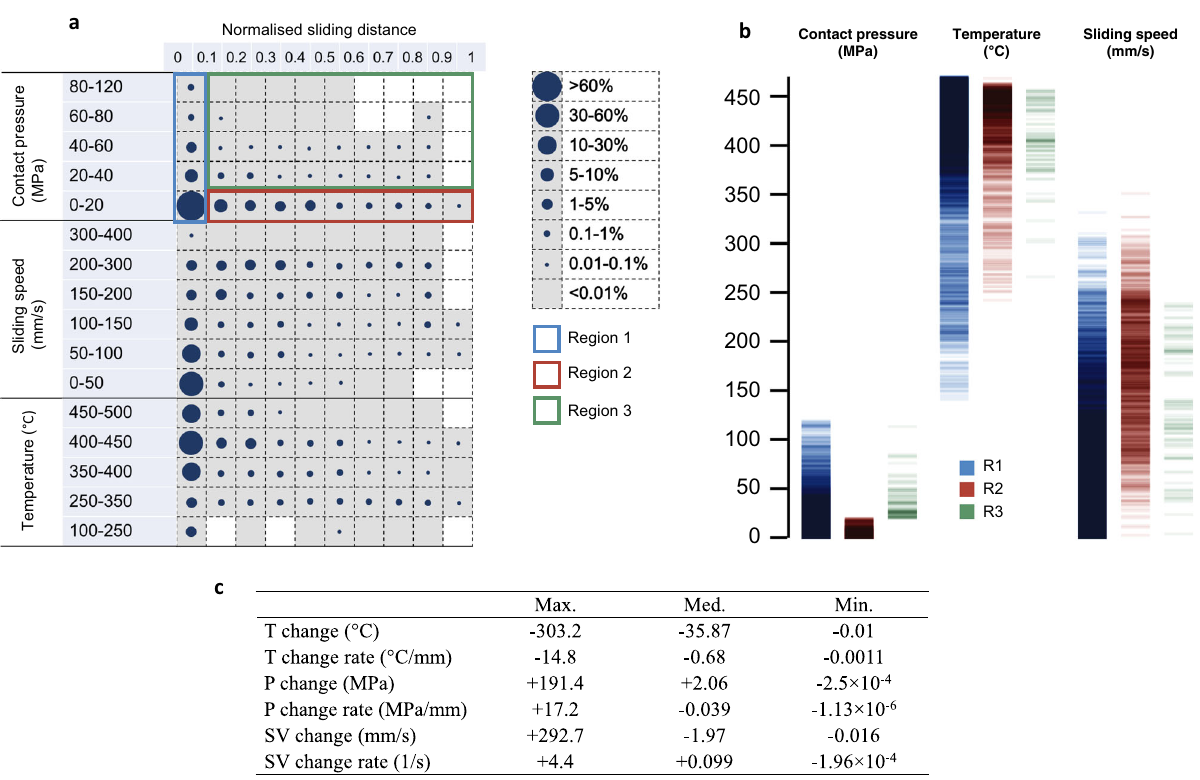
region 1 (R1), region 2 (R2) and region 3 (R3). c Maximum (Max.), median (Med.) and minimum (Min.) values of change and change rate of contact condition, i.e. temperature ( T ), contact pressure ( P ) and sliding speed (SV), during hot stamping evaluated and